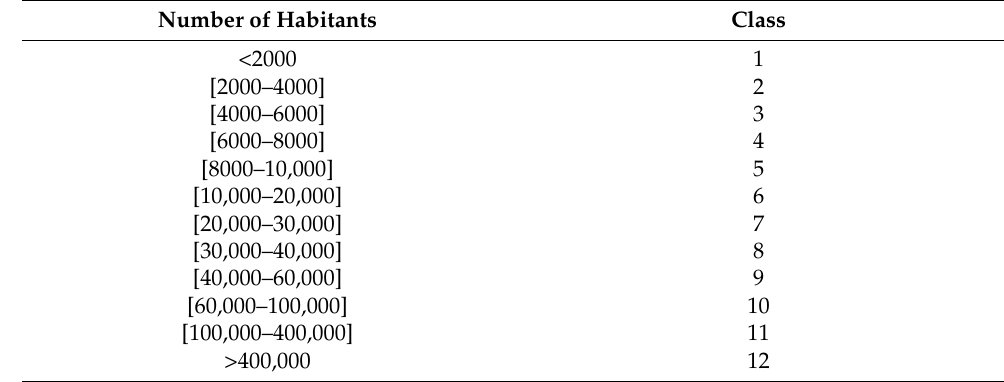
Table 1. Class division for human population (HP), depending on the number of inhabitants in each region.